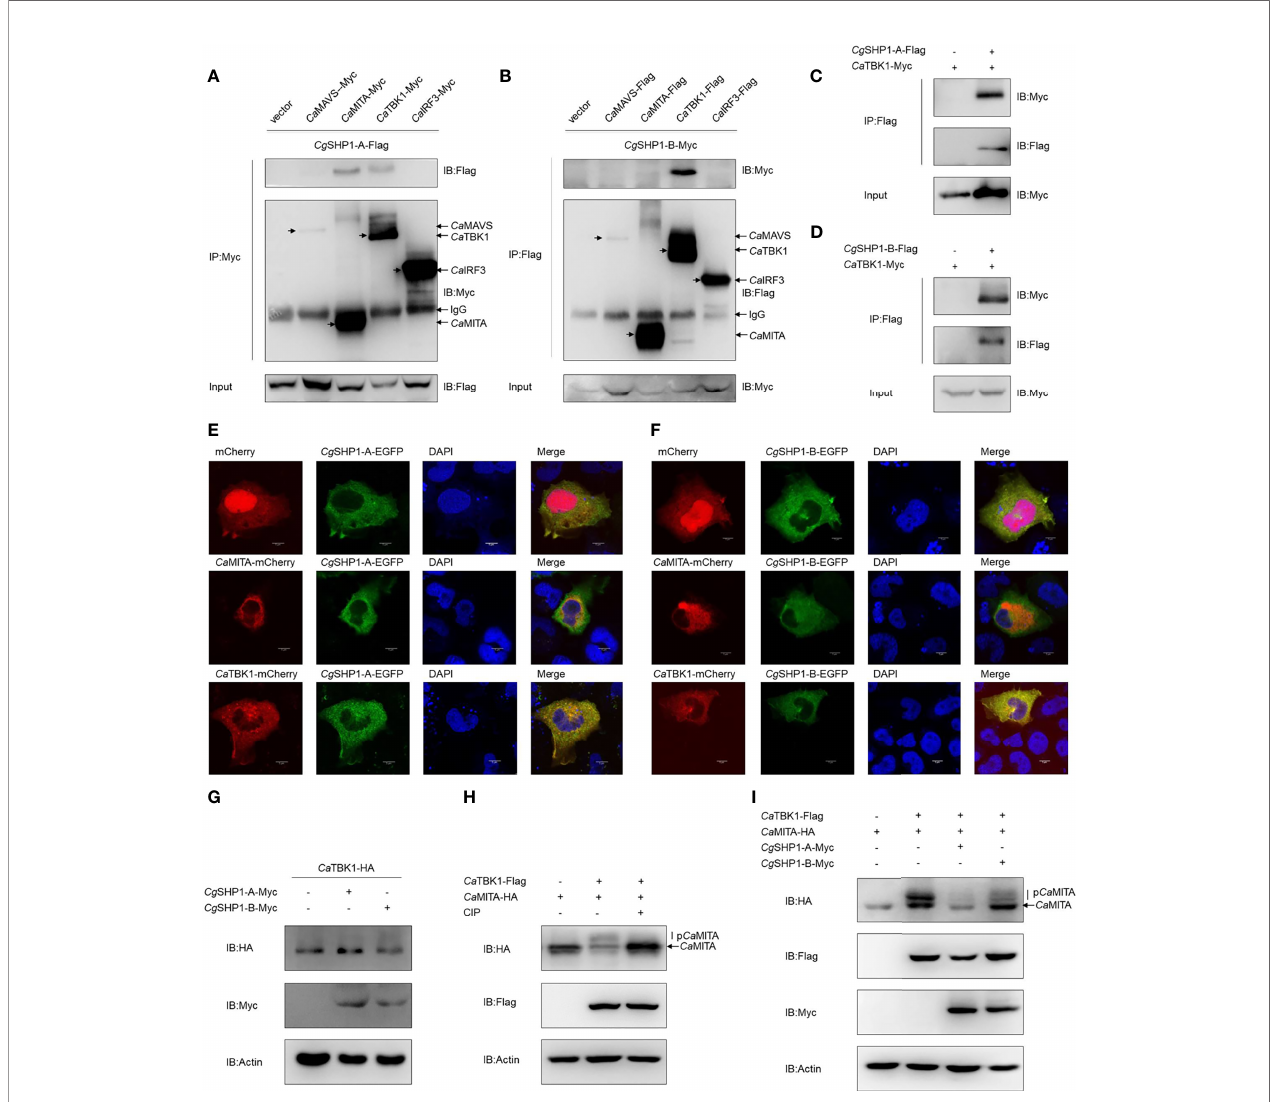
FIGURE 6 | Interaction of Cg SHP1s with Ca TBK1 and Ca MITA. (A – D) Co-IP analyses between Cg SHP1s and Ca TBK1, Ca MITA inHEK 293T cells. (E, F) Subcellular localization of Cg SHP1-A and Cg SHP1-B with Ca TBK1and Ca MITA in EPC cells. Scalebars= 5 m m. (G) Cg SHP1-A and Cg SHP1-B do not in fl uence the expression of Ca TBK1in EPC cells. (H,I) Co-IP analyses reveal Ca TBK1-mediatedphosphorylation of Ca MITA was inhibited by CIP (10 U)in HEK 293T cells (H) , Cg SHP1-A and Cg SHP1-B decrease the phosphorylation of Ca MITA induced by Ca TBK1 (I) . Allexperiments were repeatedfor at least three times with similar